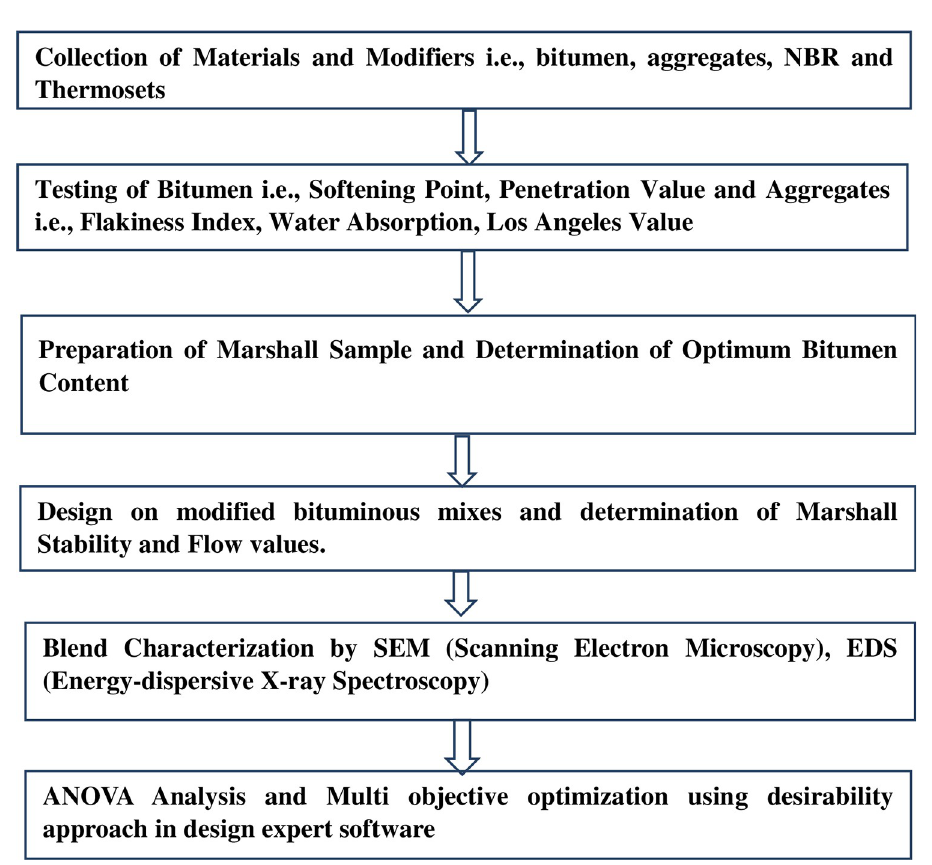
Fig 2. Research methodology to conduct laboratory work.